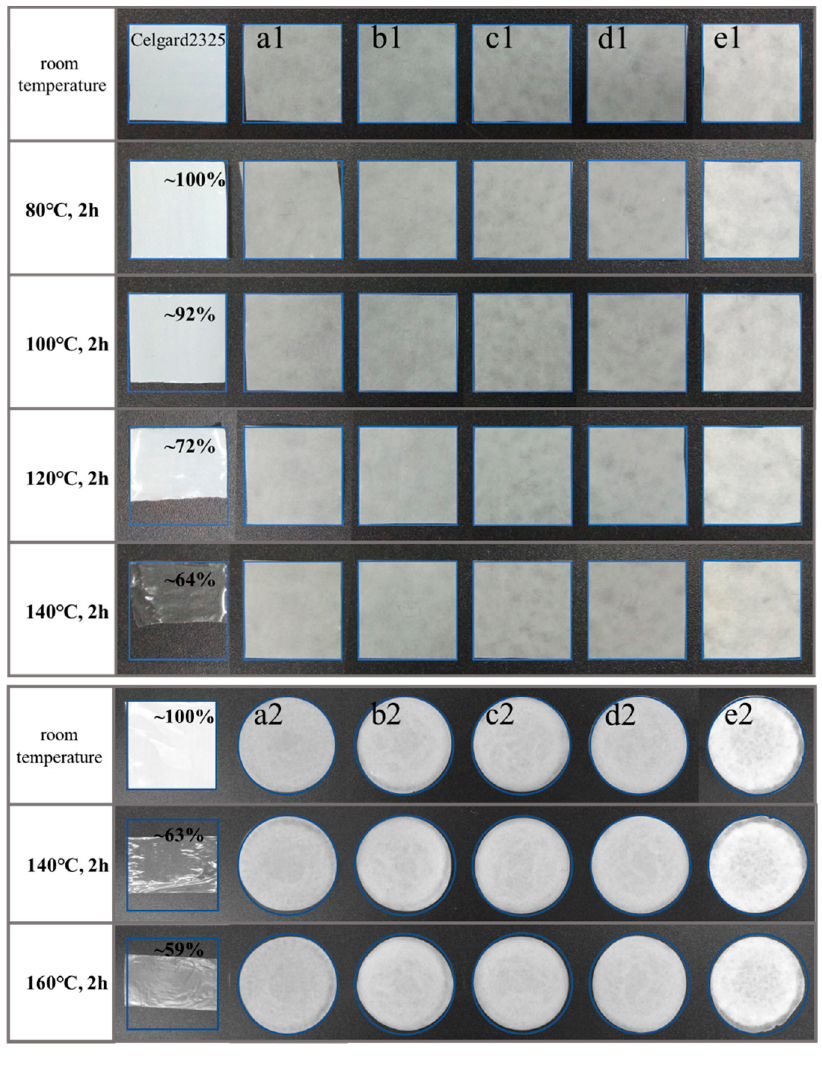
Figure 6. The thermal dimensional stability of Celgard2325 and the cellulose membranes before and after the homogenization: ( a1 , a2 ) bamboo pulp; ( b1 , b2 ) hardwood pulp; ( c1 , c2 ) softwood pulp; ( d1 , d2 ) cotton pulp; ( e1 , e2 ) hemp pulp.